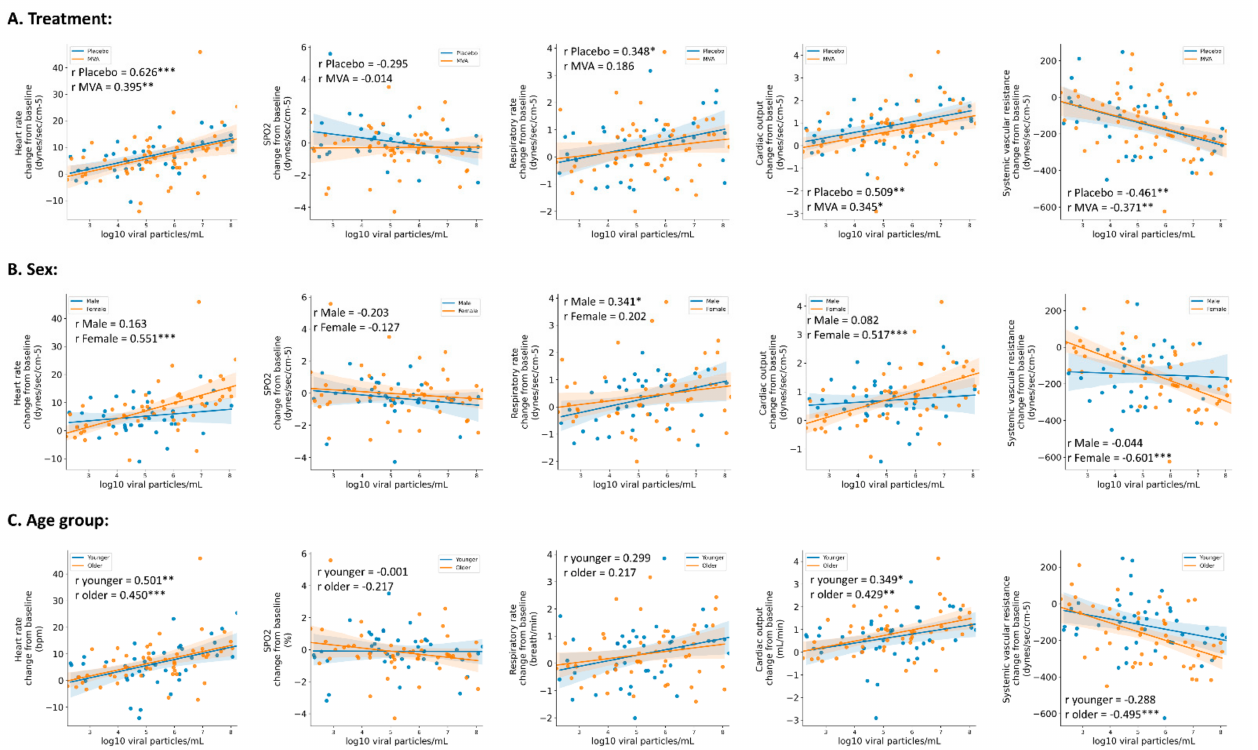
Figure 5. Correlations between viral load and changes in physiological parameters during the third-day post-exposure. Pearson’s correlations between viral loads as measured by real-time PCR and mean changes in physiological parameters from the third-day post-exposure. The correlations were stratified based on treatment (( A ) Placebo, blue dots/line; MVA, orange dots/line), sex (( B ) male, blue dots/line; female, orange dots/line), and age (( C ) younger, blue dots/line; older, orange dots/line). * p < 0.05, ** p < 0.01, *** p <